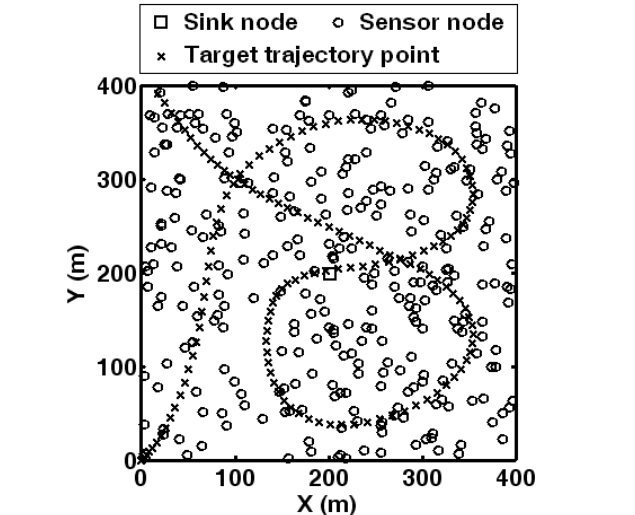
Figure 8. Deployment of WSN and the target trajectory.